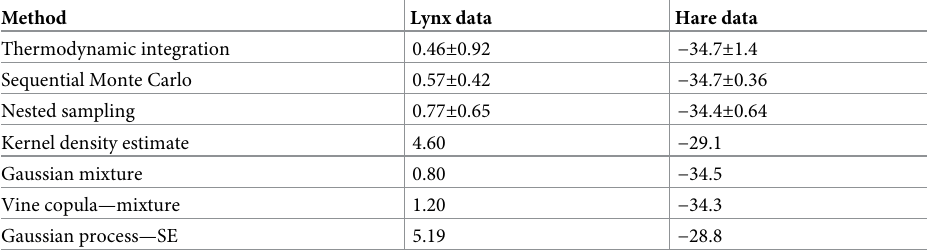
Table 1. Log marginal likelihood estimates ( ± estimation variance if